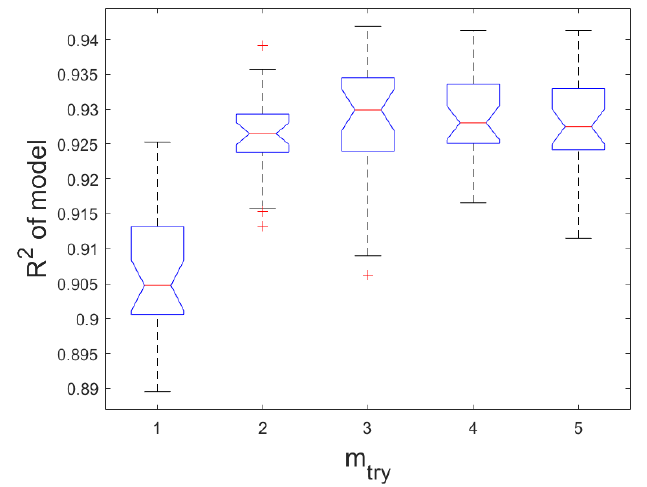
Figure 3. Effect of the random forest hyperparameter 𝑚 (cid:3047)(cid:3045)(cid:3052) on the model performance in Case 1 based Figure 3. E ff ect of the random forest hyperparameter m try on the model performance in Case 1 based on 30 runs. on 30